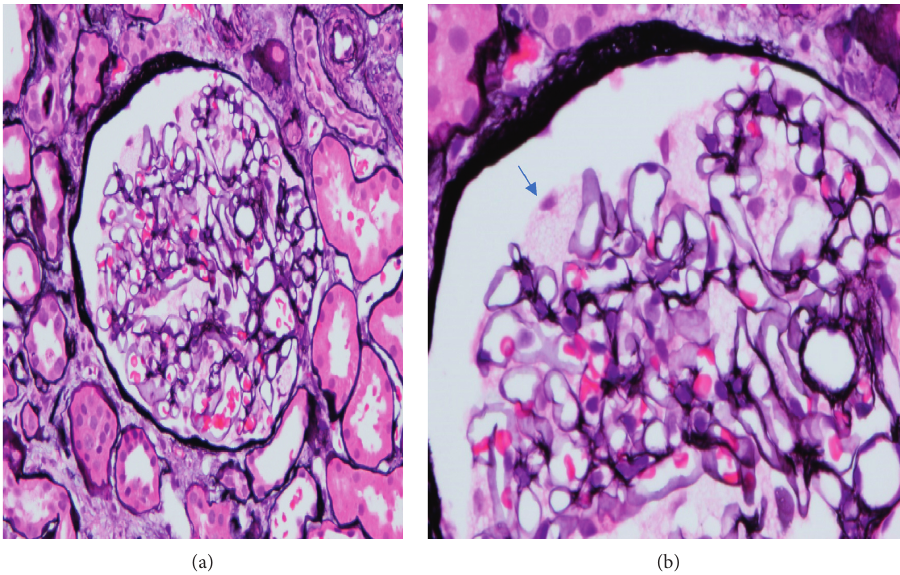
Figure 1: Normocellular glomerulus showing podocytes with foamy cytoplasm (blue arrow). Hematoxylin eosin stain; original magni- fication 200x (a) and 400x (b).